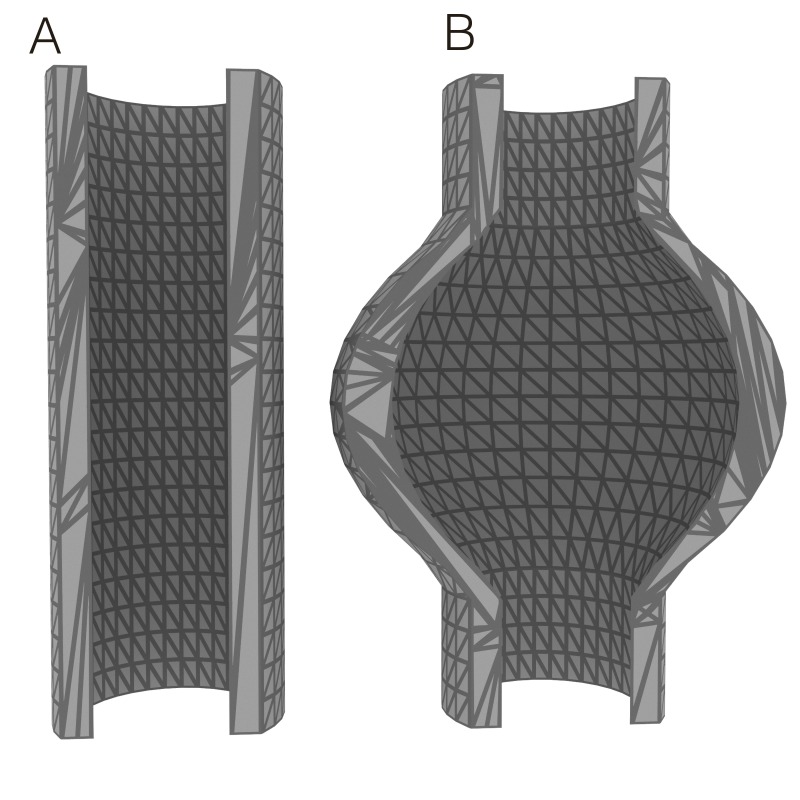
3D models of (A) cylindrical vein and (B) dilated vein, showing the increase in internal surface area of the dilated vein.